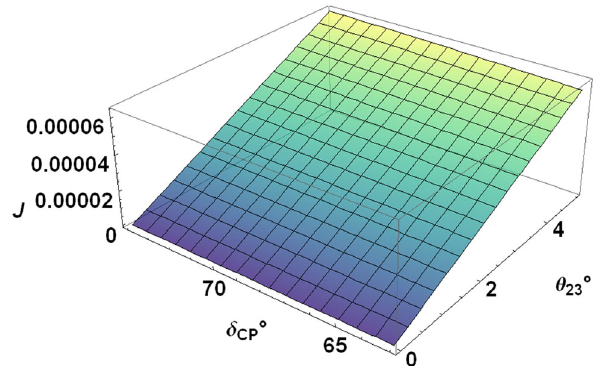
Fig. 4 Dependence of the Jarlskog invariant J on θ 23 and δ CP for quarks